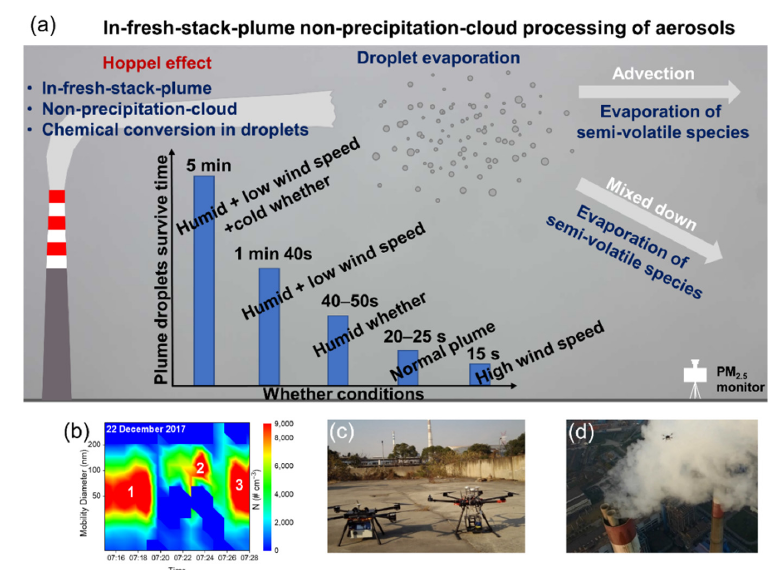
Figure 1. ( a ) Schematic of in-fresh-stack-plume non-precipitation-cloud processing of aerosols; ( b ) contour plot of particle number concentration scanned by a nano-scan particle sizer mounted on an unmanned aerial vehicle flying through fresh combustion plumes (2) and ambient air (1, 3); ( c , d ) photos taken for the measurements.